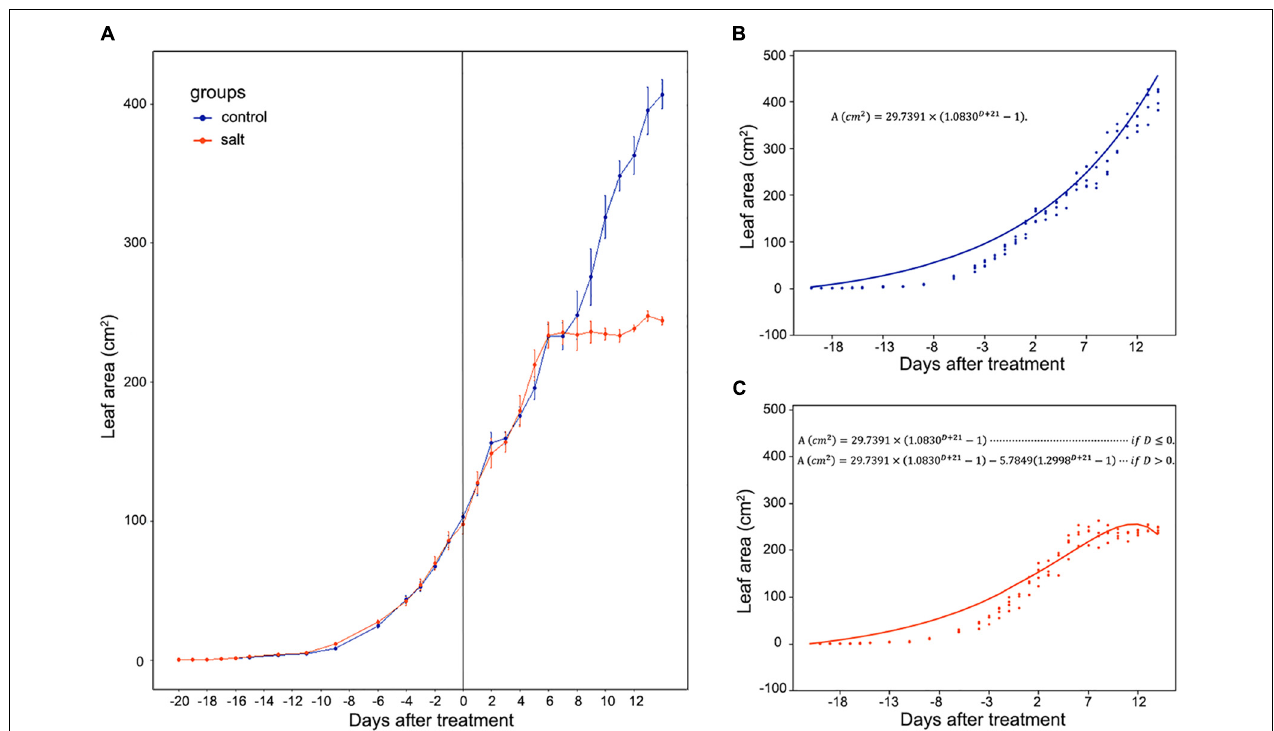
FIGURE 2 | Whole leaf area measurement of M. crystallinum seedlings during their growth for 42 days. The salt treatment began at day 0. (A) Leaf area changes in control group (blue line) and salt-treated group (orange line) of M. crystallinum . (B) Simulation of M. crystallinum growth of the control group. The line represents the simulation and the dots represent exact leaf area of each biological replicate. (C) Simulation of M. crystallinum growth of the salt treated group. The line represents the simulation and the dots represent exact leaf area of each biological